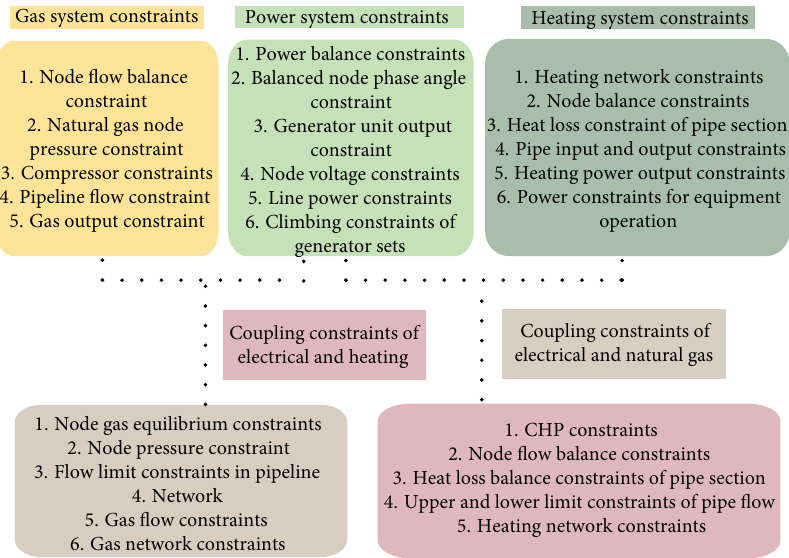
Figure 5: The specific constraints of